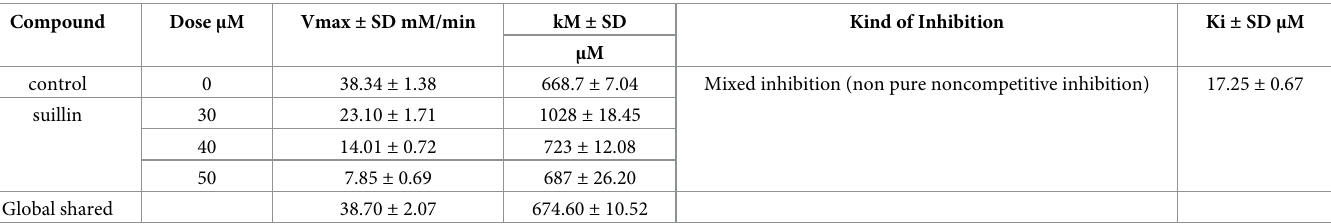
Table 2. Kinetic parameters of suillin determined for